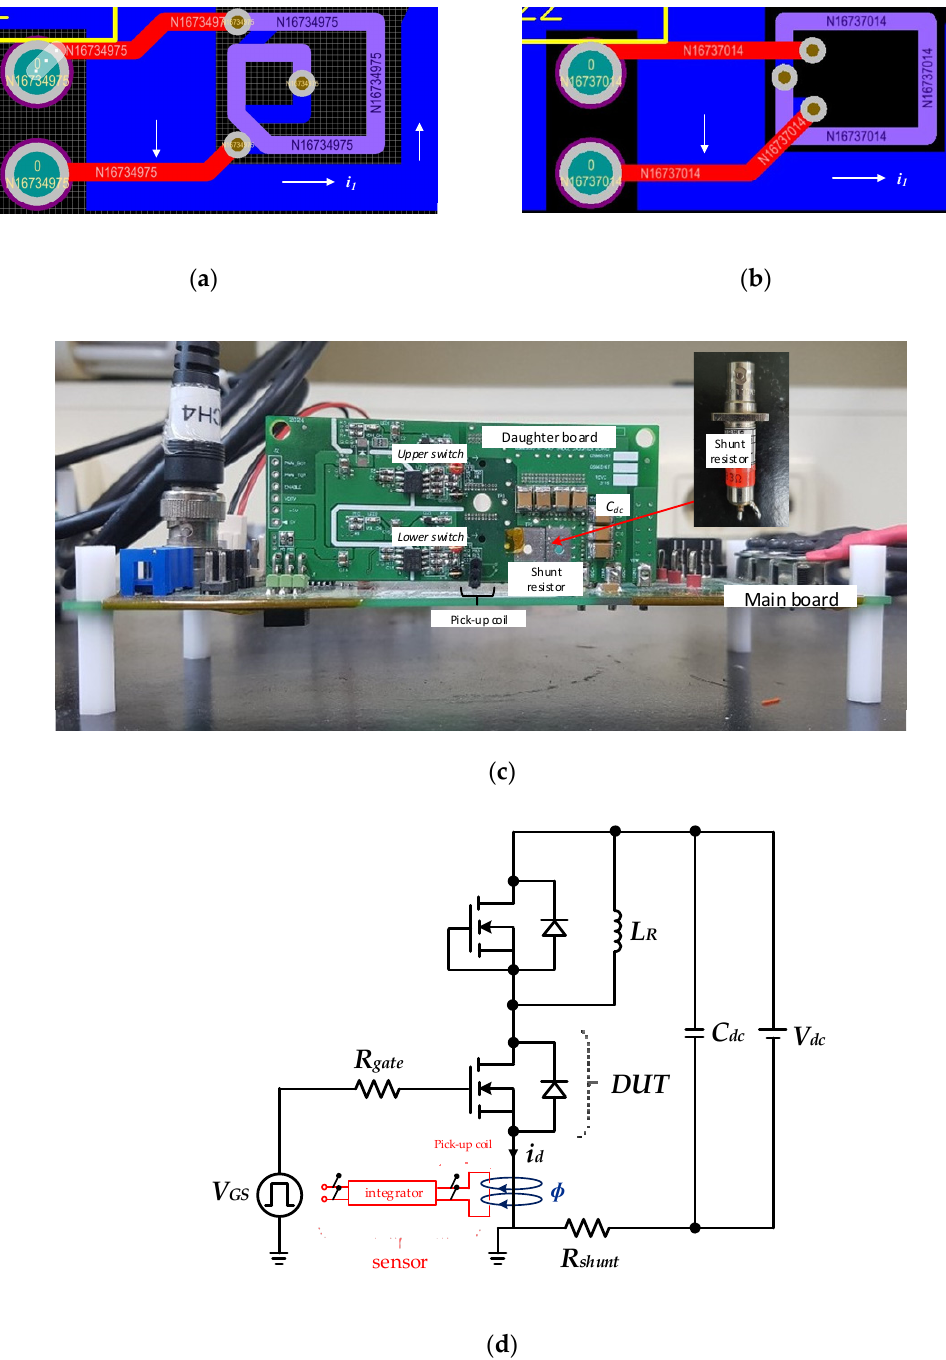
Figure 9. Prototype board of double pulse test: ( a ) Layout of spiral coil; ( b ) PCB layout of two-layer rectangle coil; ( c ) overall double pulse test board; ( d ) double pulse test circuit. Table 3. Circuit parameters of current sensor.